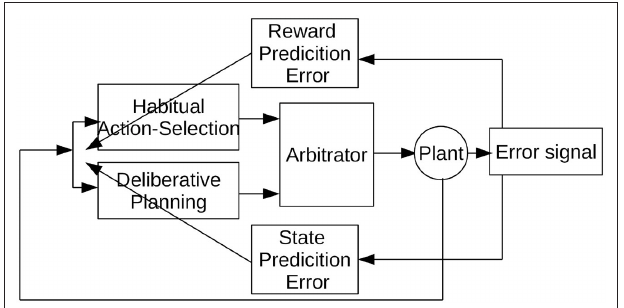
FIGURE 1 | Overview of the Arbitrated Predictive Actor-Critic (APAC) model.